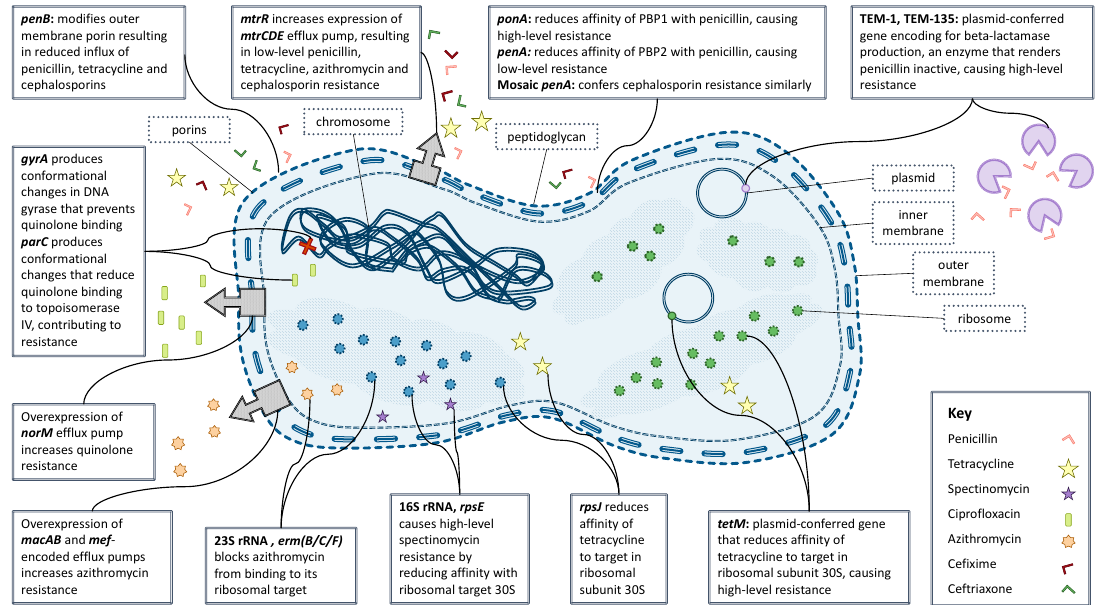
Figure 2. Known mechanisms of resistance in N. gonorrhoeae to clinically-relevant